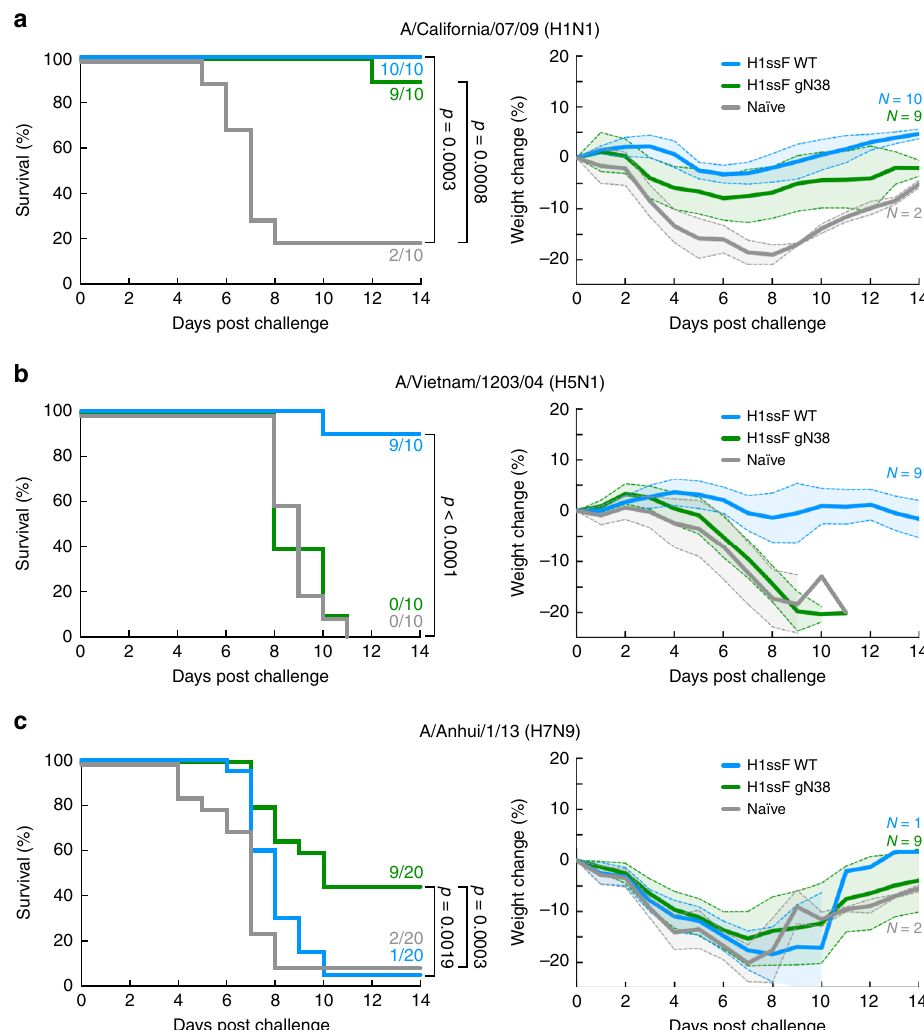
Fig. 4 Homotypic, heterosubtypic, and cross-group protection of mice immunized with H1 stem nanoparticle variants. BALB/c mice ( N = 10) were immunized with 2 µ g of H1ssF WT, H1ssF gN38 or H1ssF R38 on weeks 0, 4, and 8, and challenged between weeks 16 and 18 with 20 × LD 50 of A/ California/07/09 (H1N1) virus ( a ), 25 × LD 50 of A/Vietnam/1203/04 (H5N1) virus ( b ), or 10 × LD 50 of A/Anhui/1/13 (H7N9) virus ( c ). All viruses were given intranasal inoculation. Mice were monitored twice daily for their weight and activity for 14 days post infection. Survival curve (left) and associated weight loss curve (right) were plotted for each virus challenge ( a – c ). For weight loss curves, lines indicate group mean ± s.d. (shaded). Statistical test to compare multiple Kaplan – Meier curves was carried out by using Mantel-Cox log-rank test with Bonferroni correction. Displayed results are representative of two independent experiments (H1N1 and H5N1) or cumulative of two experiments (H7N9). Source data are provided as Source Data fi